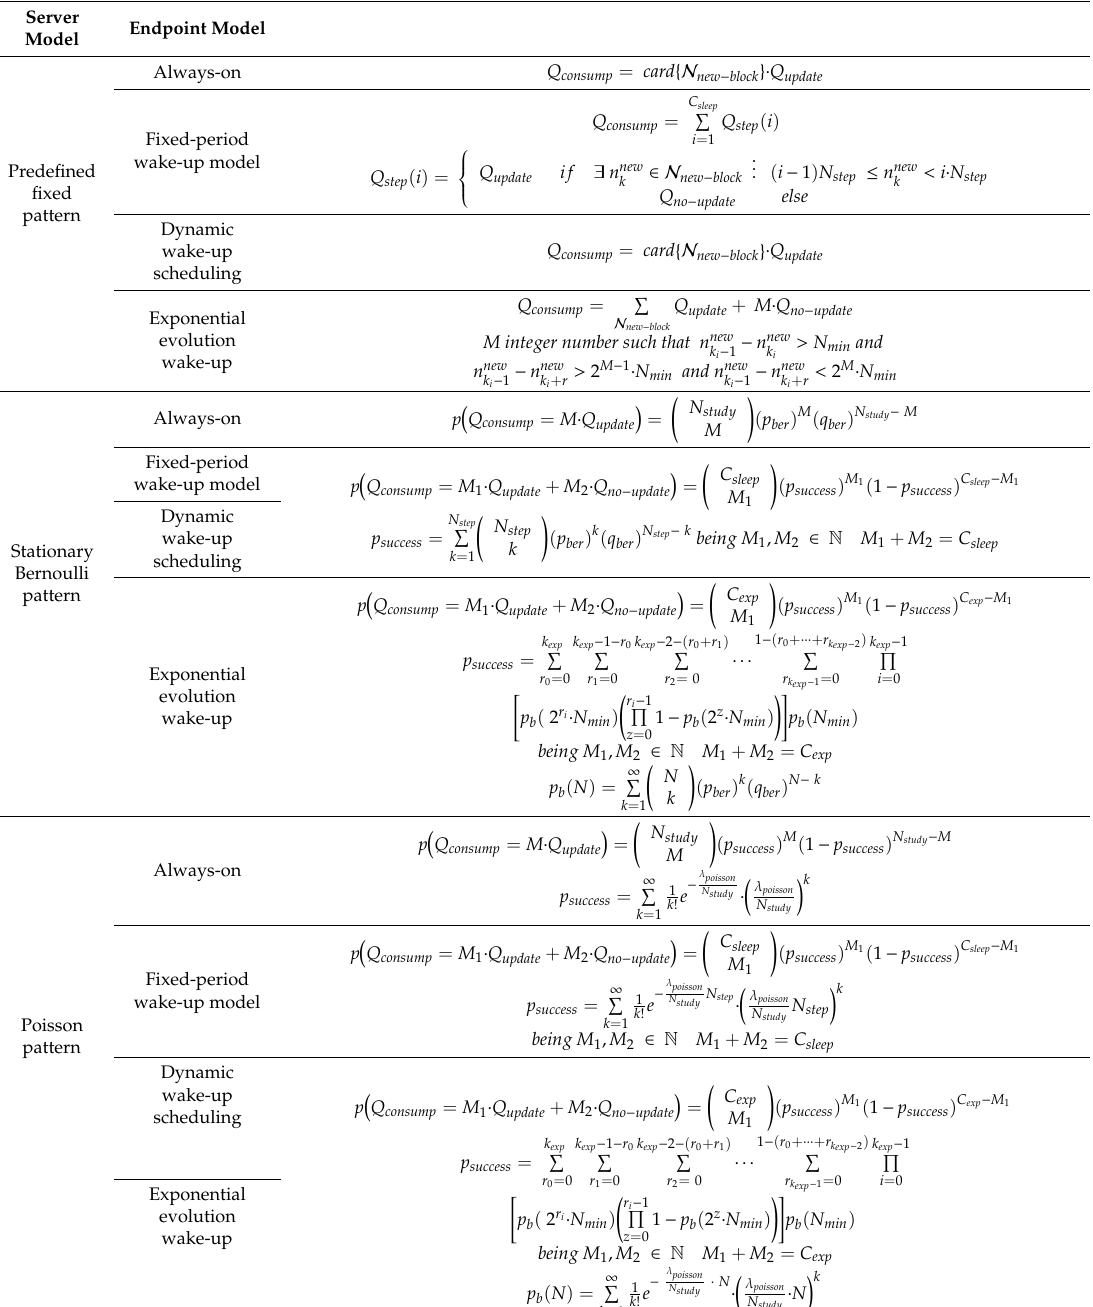
Table 6. Information consumption cost in the proposed scenario. Random